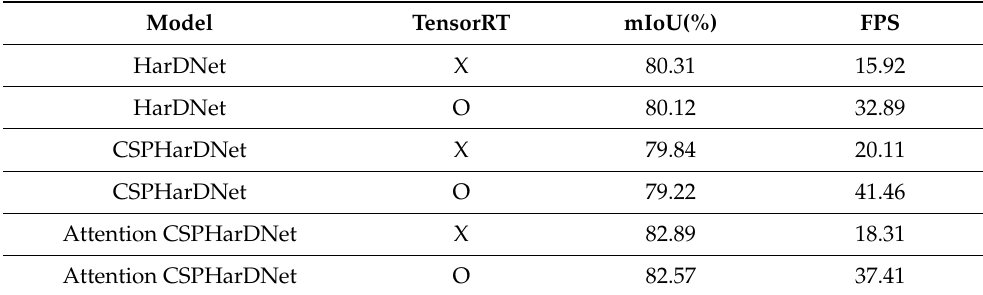
Table 6. TensorRT performance comparison.